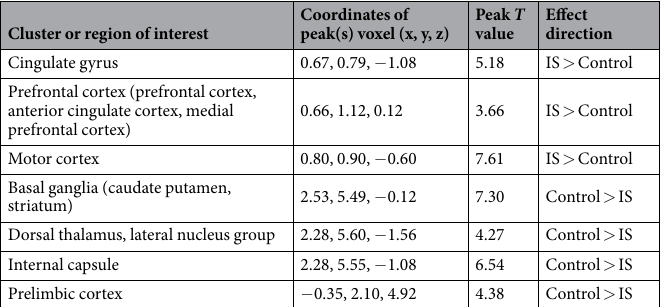
Cluster or region of interest